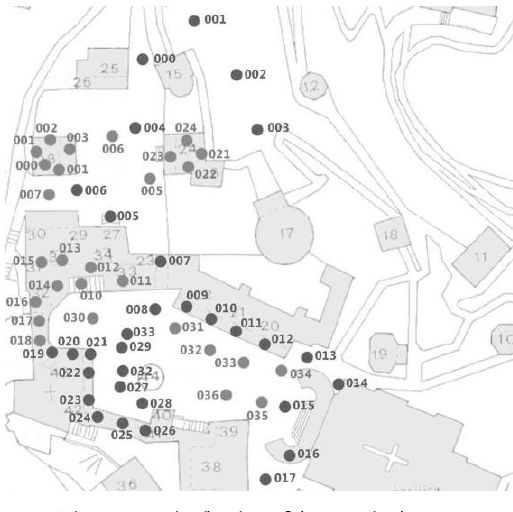
Figure 11. Distribution of the acquired